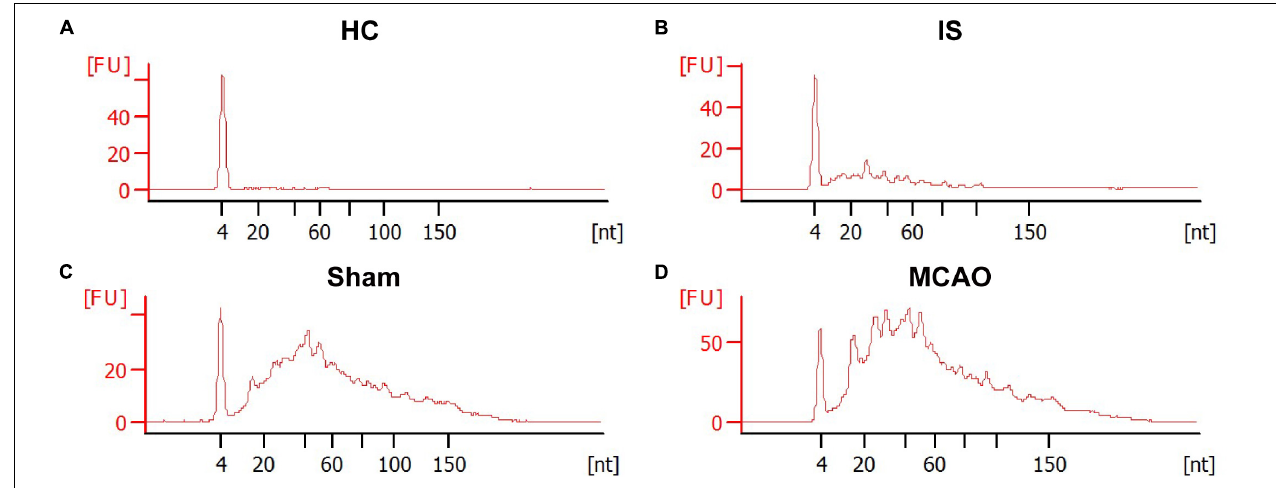
FIGURE 3 | The size distribution and relative abundance of sEVs RNA from IS patients and healthy controls, and tMCAO mice and sham controls. The electropherograms delineate the size distribution in nucleotides (nt) and fluorescence intensity (FU) of small RNA in serum sEVs. The representative electropherograms of HCs (A) and IS patients (B) ; sham (C) and tMCAO mice (D) .